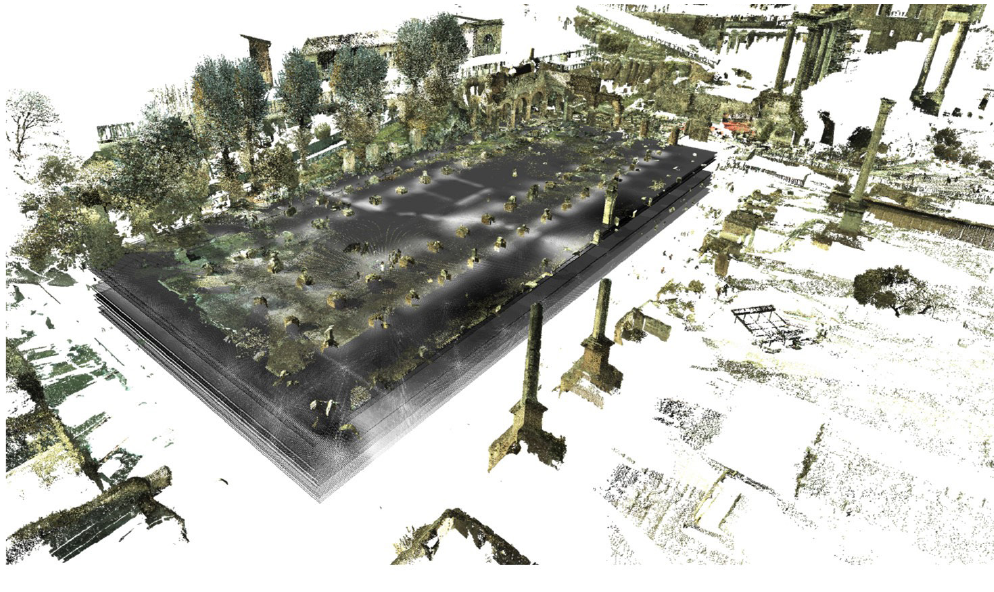
Fig. 15 Griffo M., Julia Basilica, Overlay between 3D point cloud from scanner and magnetic